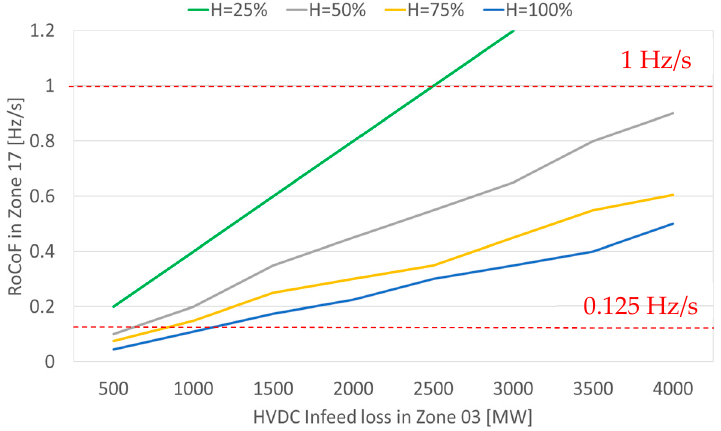
Figure 15. Zone 17 RoCoF variation with infeed loss and system inertia. The value of 100% inertia refers to the HVDC trip on 20 April 2018.